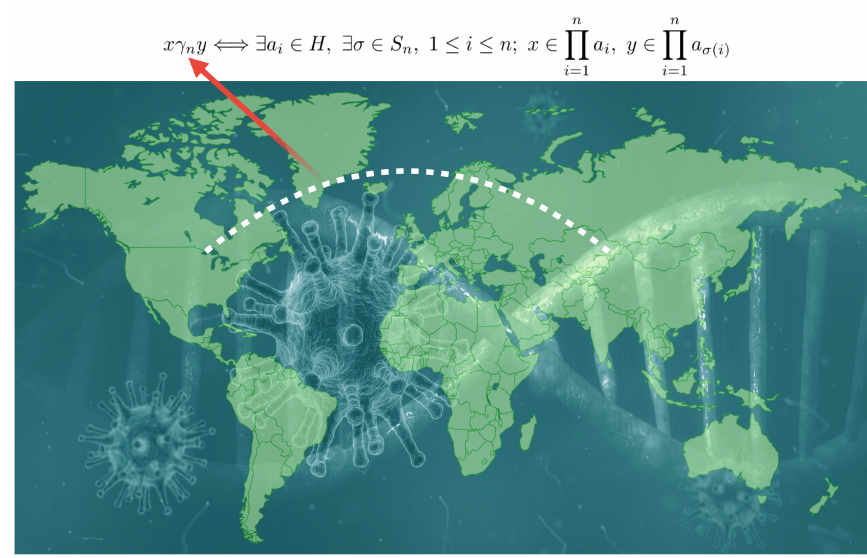
Figure 1. SBG for modeling global spread of COVID- n